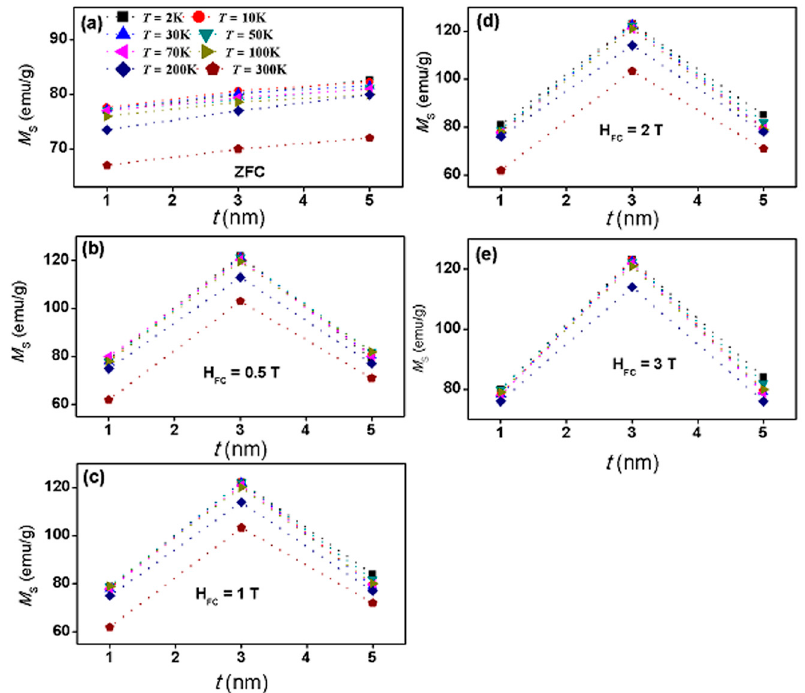
Figure 4. The saturation magnetization versus the shell thickness at several temperatures (from 2 to 300 K) ( a ) in the ZFC state as well as in the field-cooling (FC) state at several field-cooling values of ( b ) 0.5 T, ( c ) 1 T, ( d ) 2 T, and ( e ) 3 T.